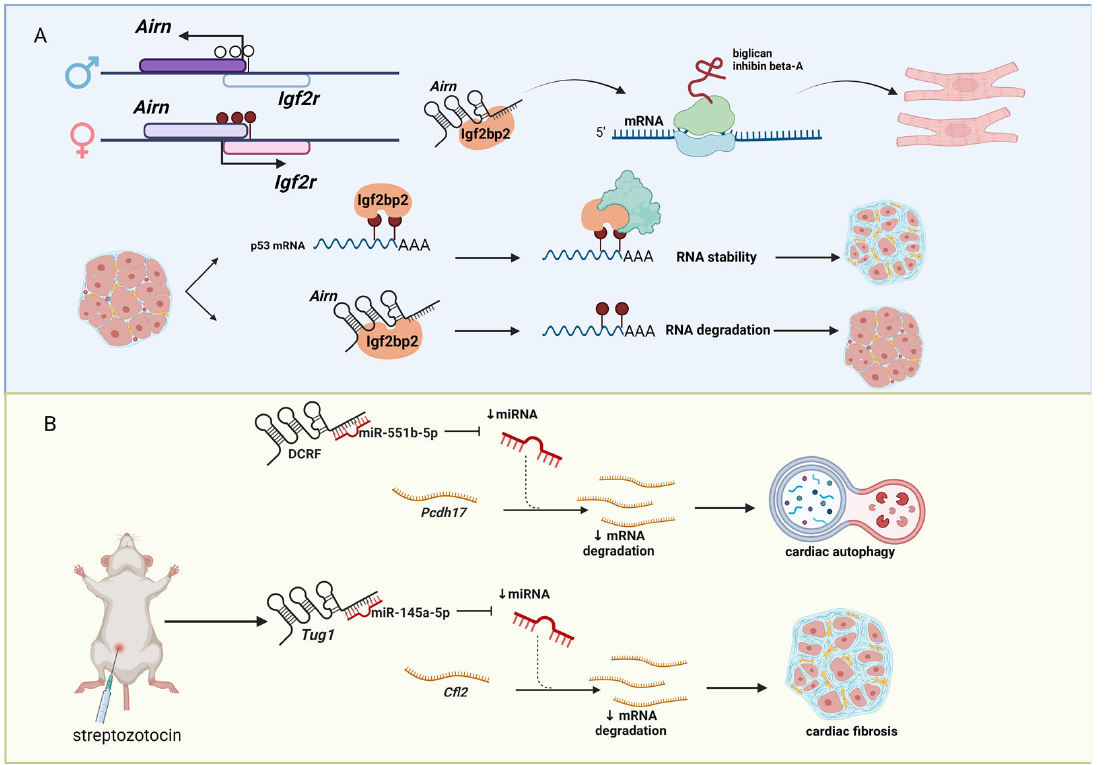
Figure 3. LncRNAs associated with diabetes. ( A ) The lncRNA Airn is paternally imprinted and located in antisense orientation to the maternally imprinted derived protein-coding gene Igf2r . Airn binds to the RNA-binding protein Igf2bp2 and controls the translation of mRNAs (e.g., biglycan and inhibin β -A) to modulate the resistance to stress in cardiomyocytes. Similarly, in diabetic cardiac fibrosis, Airn binds to Igf2bp2 to regulate the degradation of Trp53 mRNA in a m 6 A manner. ( B ) Several lncRNAs are involved in diabetic cardiomyopathy (DCM) by functioning as miRNA sponges. The lncRNA DCRF sequester miR551b-5p targets protocadherin 17 mRNA to regulate autophagy in rat cardiomyocytes. The upregulation of the lncRNA Tug1 in the DCM streptozotocin- based mouse model leads to an increasing level of extracellular matrix and myocardial fibrosis development. Figure created with BioRender.com (accessed on 9 December